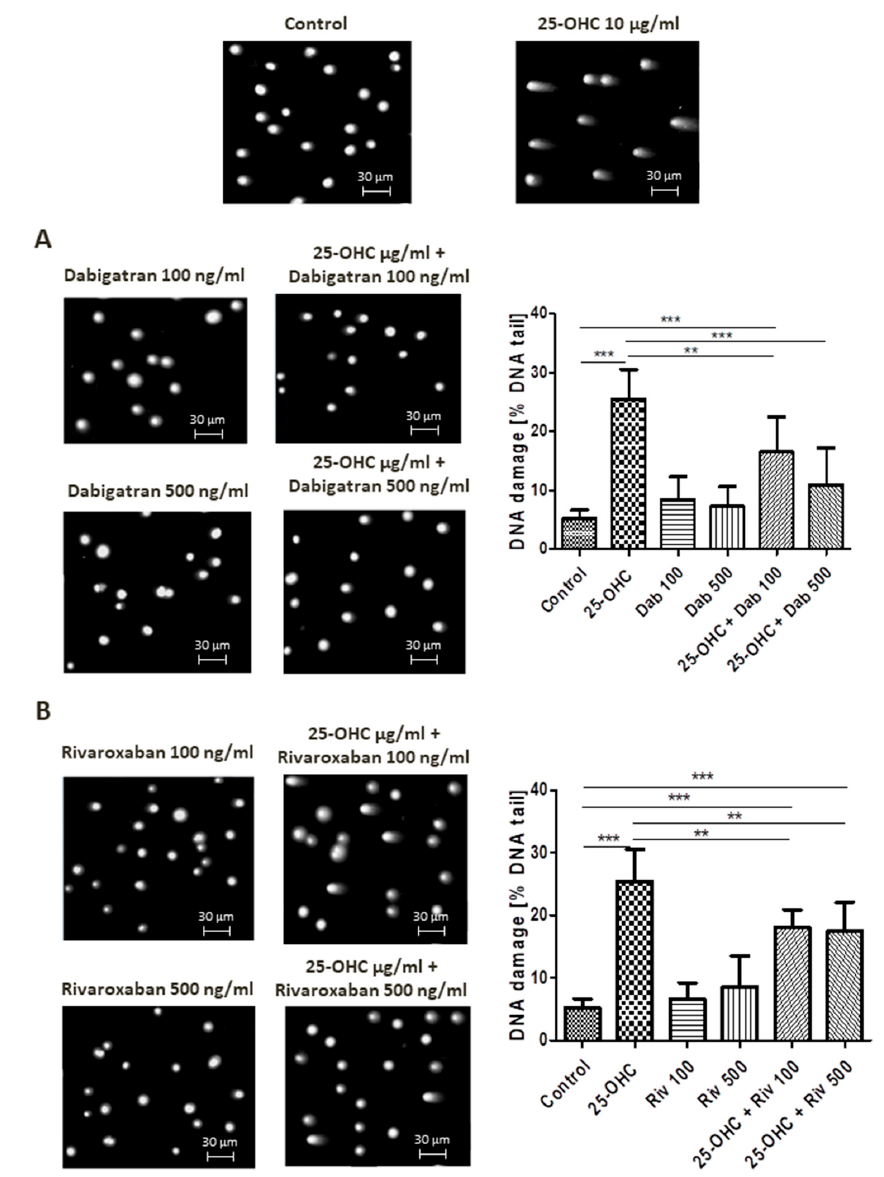
Figure 1. Selected photographs of DNA (comets) of human umbilical vascular endothelial cells (HUVECs) incubated with 25-hydroxycholesterol (10 µ g / mL), ( A ) dabigatran and ( B ) rivaroxaban (100 ng / mL and 500 ng / mL). The photos were achieved using a fluorescent microscope with 200 × magnification. Scale bars in images were added. The level of DNA strand breaks in HUVECs was determined by single-cell gel electrophoresis (comet assay). DNA damage in HUVECs was induced by 25-hydroxycholesterol, the repair of DNA damage in HUVECs was induced by ( A ) dabigatran and ( B ) rivaroxaban. DNA damage was measured as a percentage of DNA in the comet tails. Each experiment included a positive control (PC) treated with hydrogen peroxide at 20 µ M (% DNA tail: 45.8 ± 8.5). The number of cells scored for each slide was 100. Mean ± SEM was calculated from four individual experiments (400 comets). Significant differences from negative control are indicted by ** p < 0.01; *** p < 0.001. Statistical analysis was conducted using one-way ANOVA and a post-hoc Tukey’s